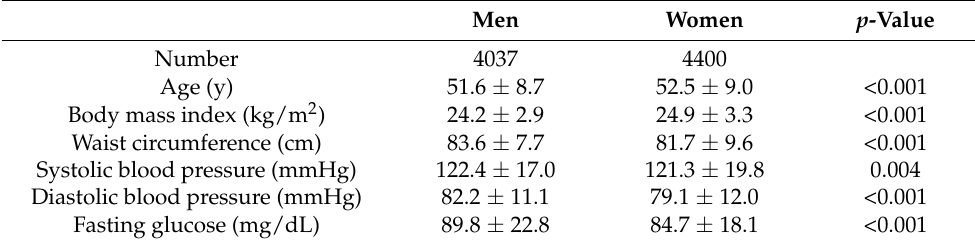
Table 1. Baseline characteristics of the study